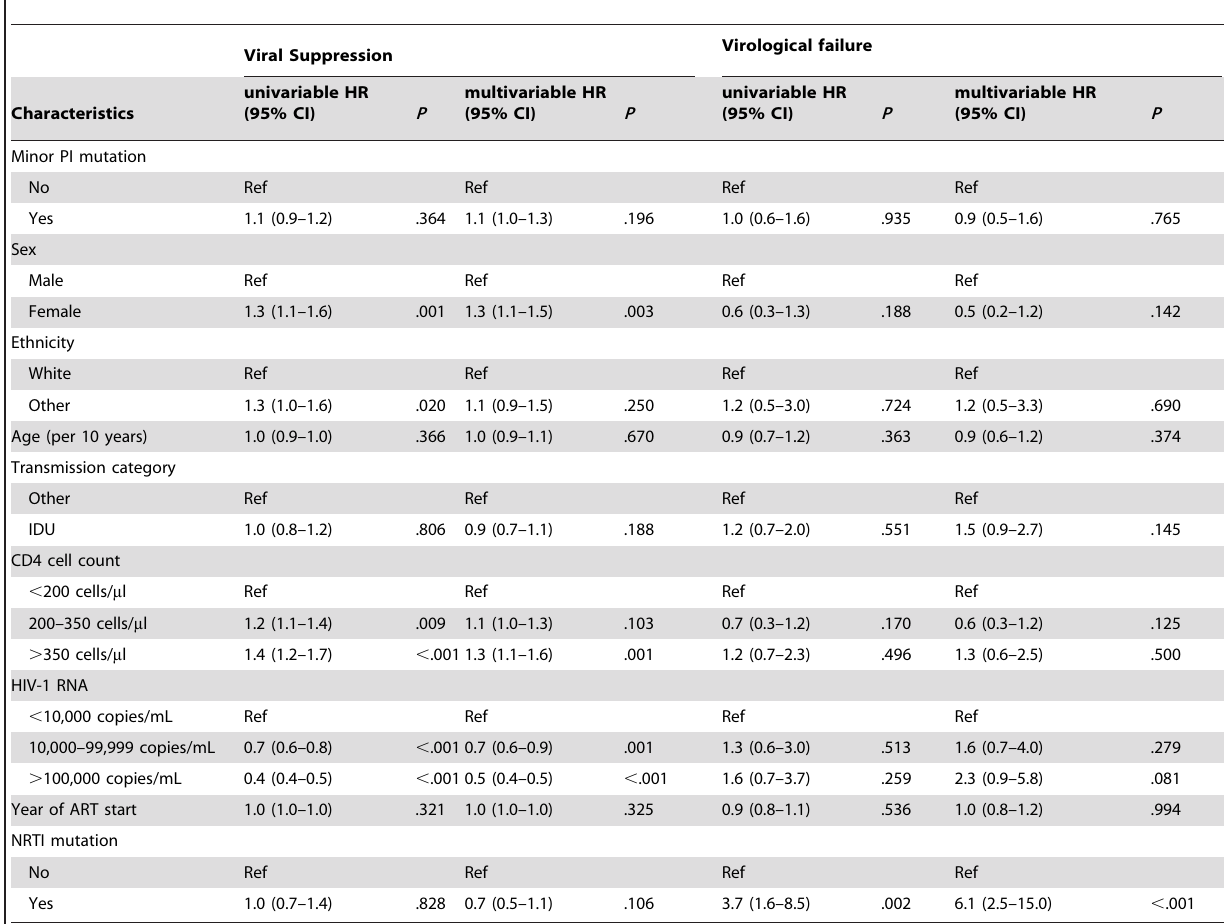
Table 2. Cox regression models analyzing time to viral suppression and time to virological failure. Models were stratified for the administered